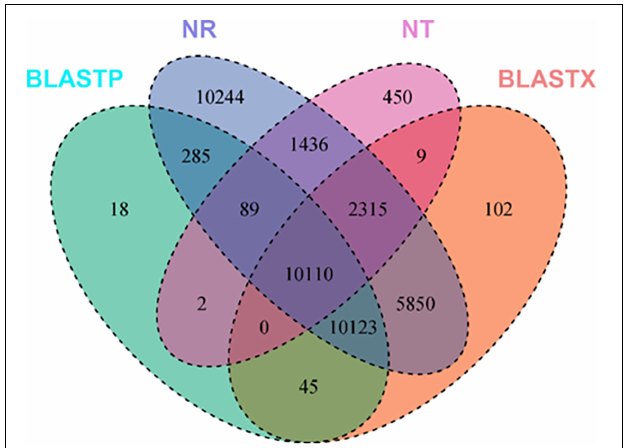
FIGURE 1 | Number of annotated de novo assembled unigenes of S. argel plants using different tools, e.g., Blastx, Blastp, HmmScan, SignalP, TmHMMP, and RNAmmer against several databases, e.g., UniProt (NT), RefSeq non-redundant (NR) protenis, KEGG Orthology (KO), and gene ontology (GO) term